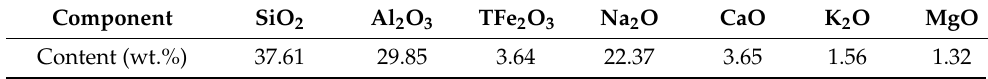
Figure 2. XRD analysis of CFA samples roasted at different temperatures ( a ) 400 °C ( b ) 600 °C and after water leaching of the cake ( c , d ). Table 3. Chemical composition of the sample after water leaching.